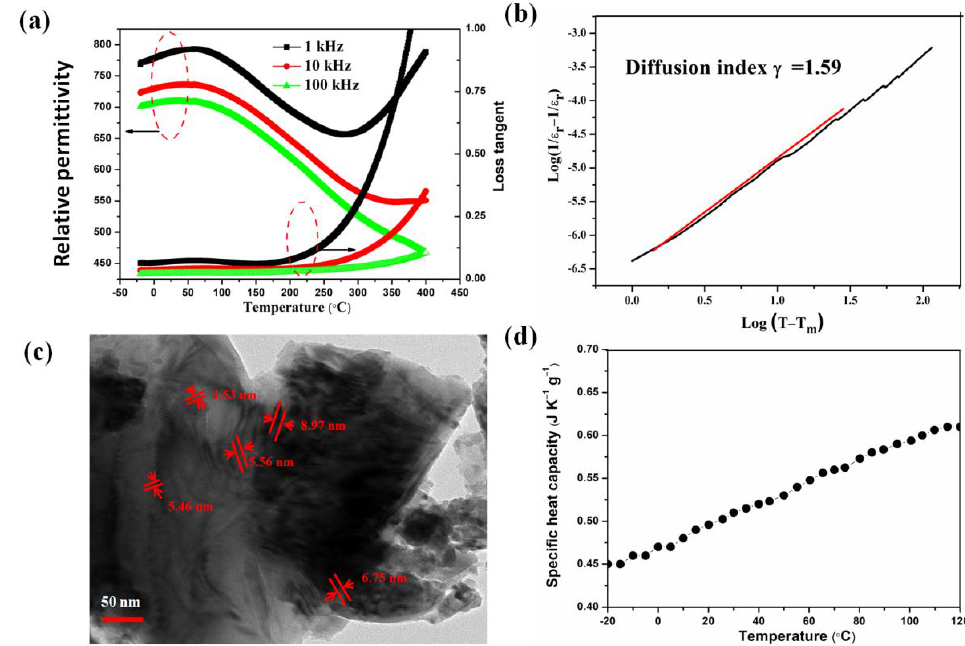
Figure 5. ( a ) Dielectric properties versus temperature at three selected frequencies (1 kHz, 10 kHz − 1 and 100 kHz). ( b ) Plot of log( 1 ) as a function of log ( T − T m ) at 100 kHz. ( c ) TEM image of polar ε r ε m nanodomain regions (PNRs) in the sample. ( d ) Measured specific heat capacity of the KN-BT(9/1) ceramics. Note that the bimodal structured KN-BT(9/1) bulk ceramic sintered at 1050 °C using IAGG method was selected for the analysis.